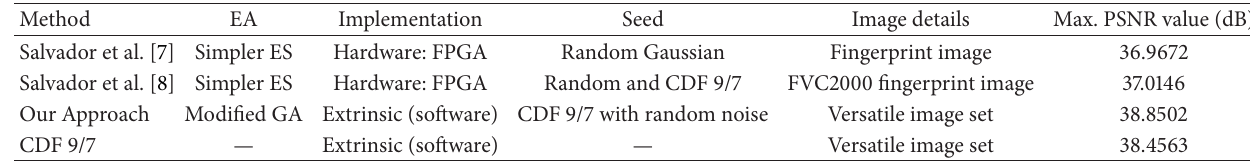
Table 7: Comparison of other implementation